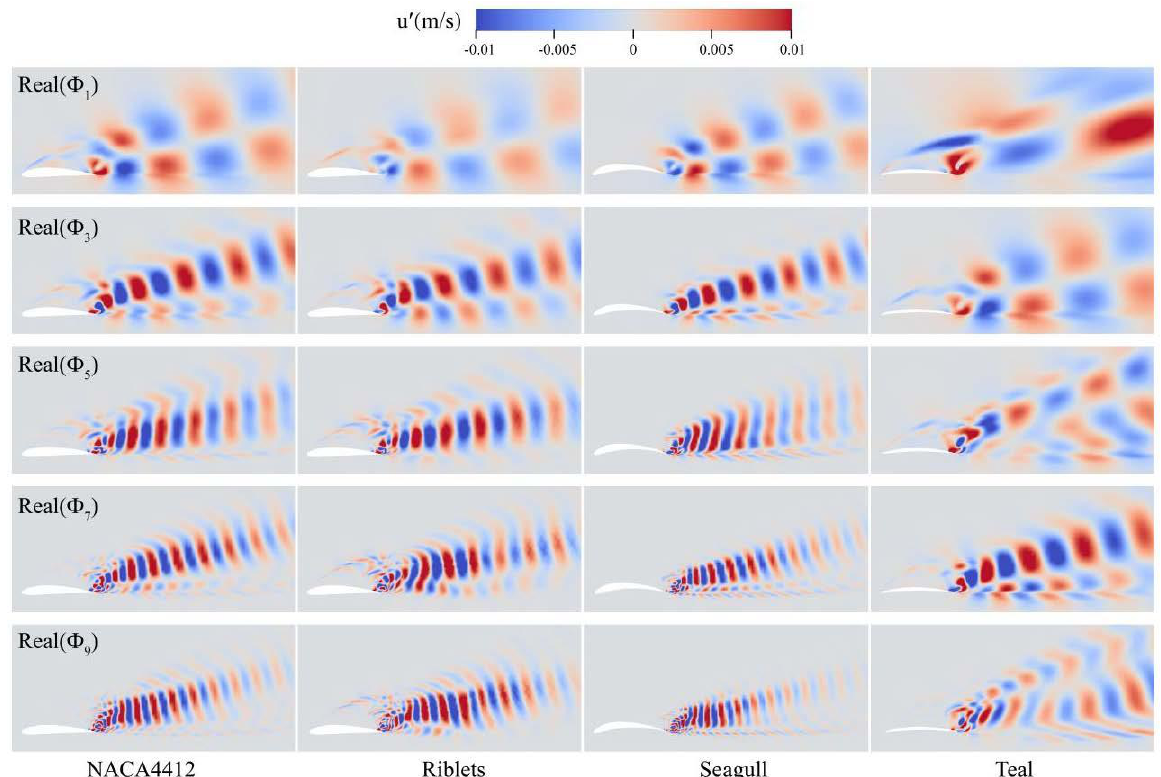
Figure 7. Mode comparison of the NACA4412, Riblets, Seagull, and Teal airfoil.